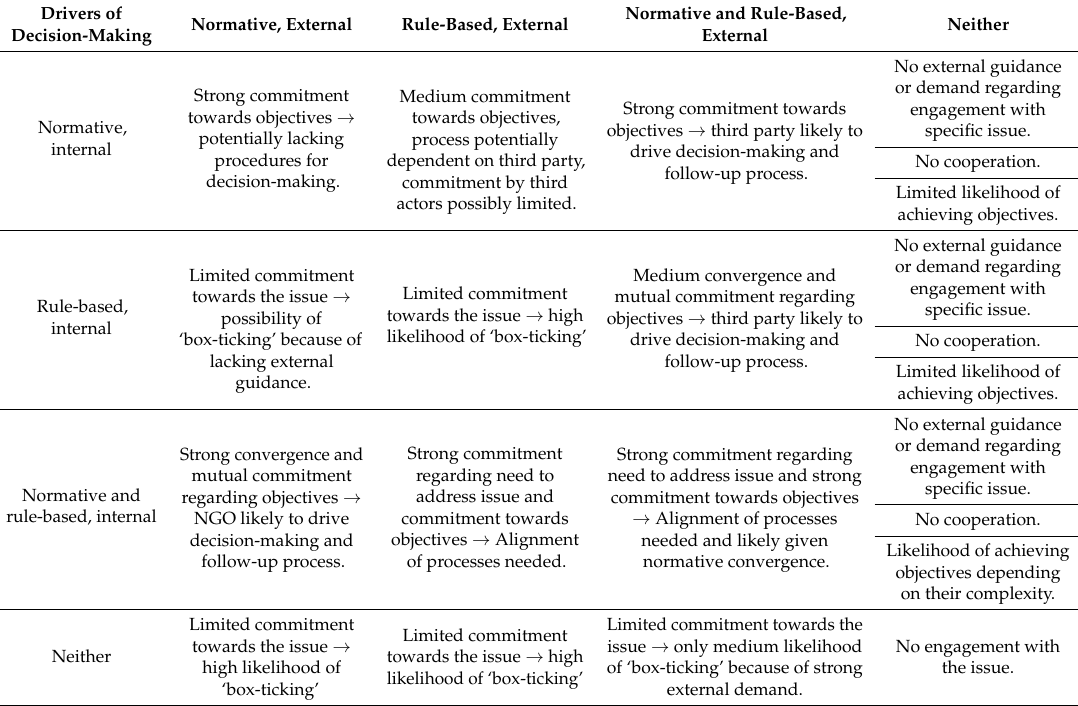
Table 3. Schematic representation of drivers of decision-making and